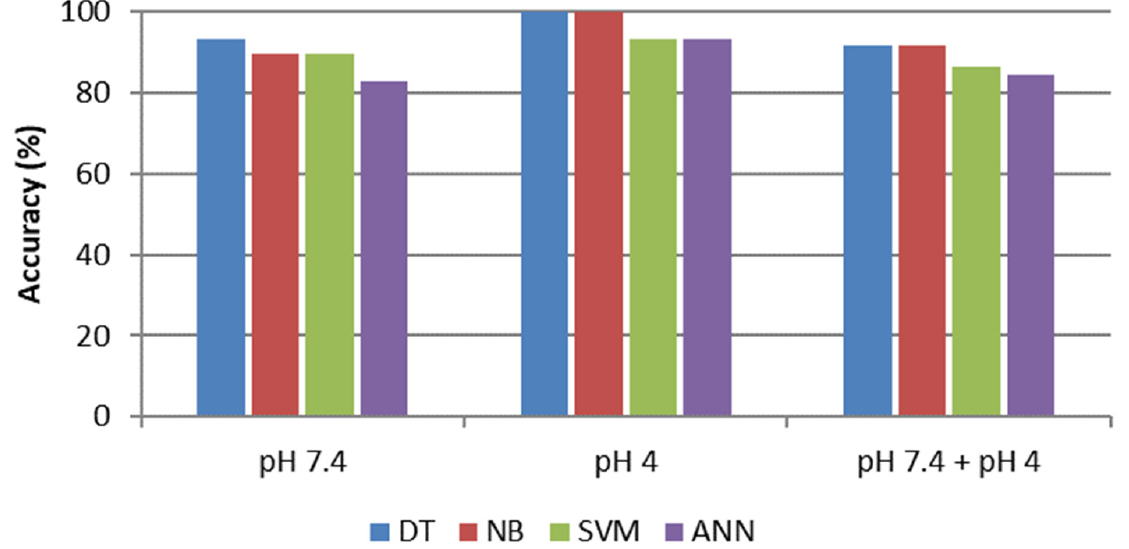
Figure 7. Testing classification accuracy for copper ion discrimination in DMEM at different pH conditions.